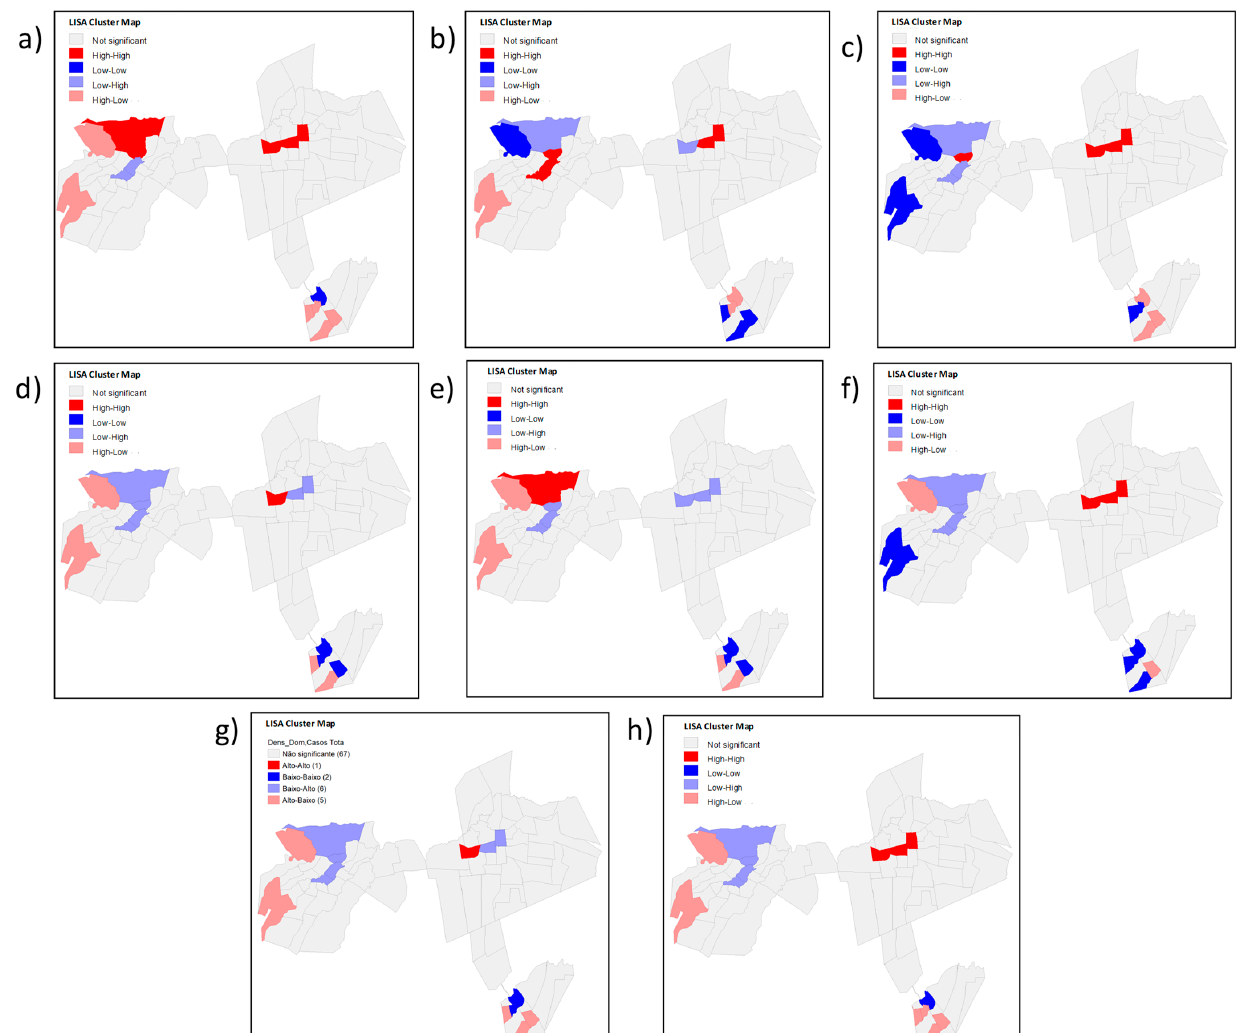
Figure 5. Local bivariate correlation map using the total number of cases of COVID-19 in the neighborhoods as a dependent variable and PEVI and its indicators as independent variables: ( a ) low income distribution; ( b ) persons aged 60 or over; ( c ) population density; ( d ) people in the situation of poverty and extreme poverty; ( e ) households without water supply and bathroom; ( f ) absence of urban infrastructure; ( g ) household density; ( h ) total number of COVID-19 cases per neighborhood.